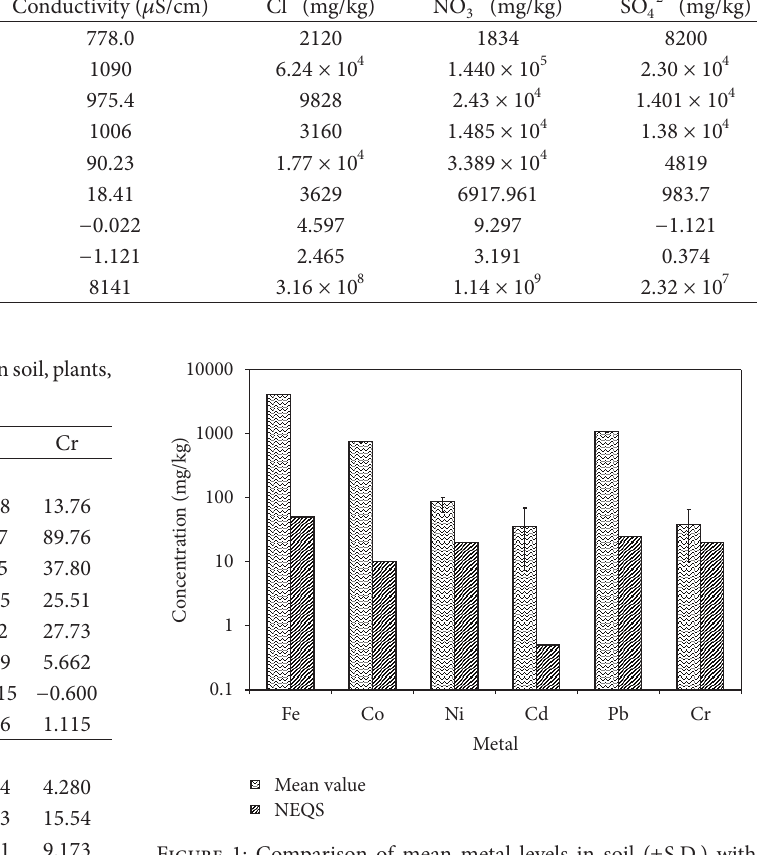
F 1: Comparison of mean metal levels in soil (